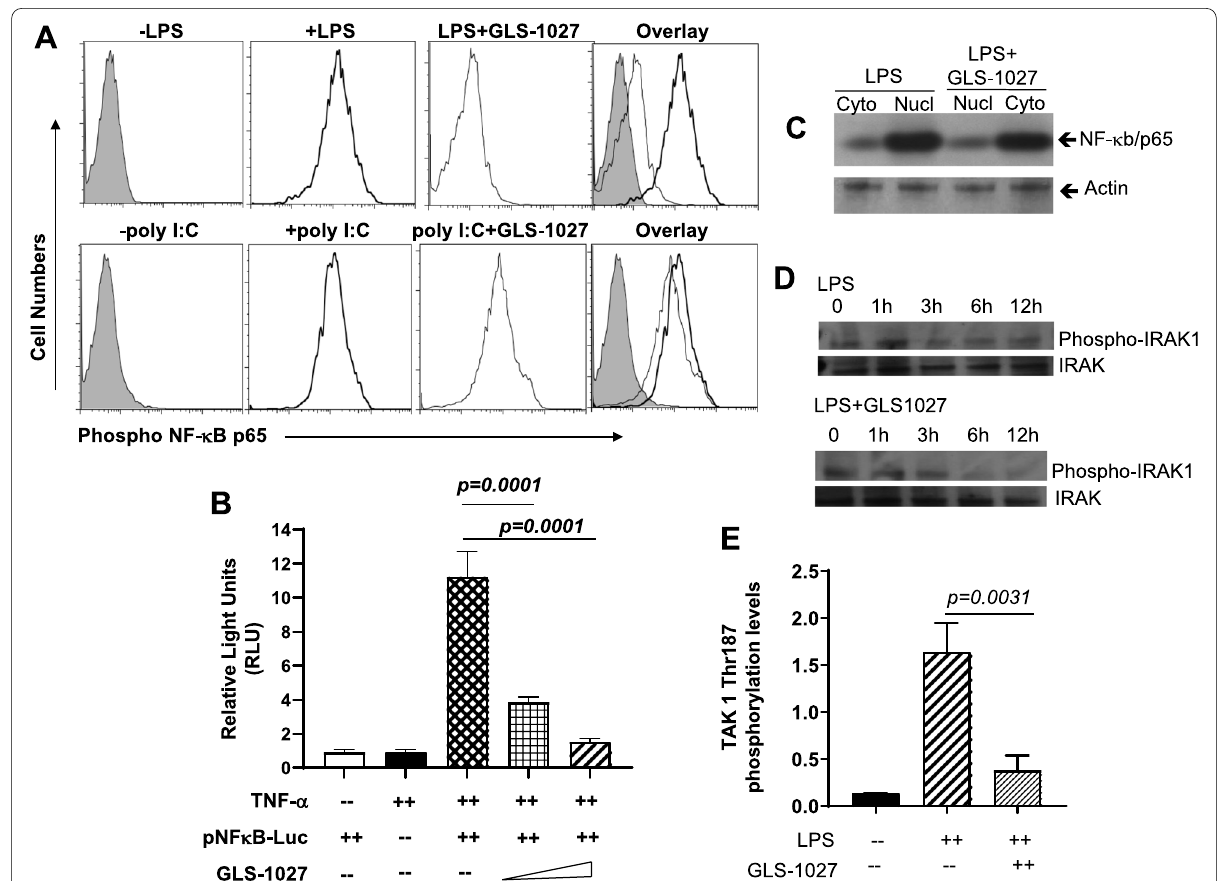
Fig. 2 GLS-1027 inhibits the activation of NF-κB and p38 pathways induced by LPS, but not by Poly(I:C). ( A ) Flow-cytometric analysis of phospho NF-κB -p65 in monocytes after LPS and poly I:C stimulation in the presence or absence of 10 µM of GLS-1027 in vitro. After stimulation, cells were fixed and permeabilized. The cells were stained with fluorochrome-conjugated antibodies against the CD14 monocyte cell surface marker and phospho NF-κB -p65. The CD14-positive monocyte population was analyzed for intracellular levels of phosphorylated NF-κB using flow cytometry with the data displayed as histograms. ( B ) Inhibition by GLS-1027 of NF-κB (p65) DNA binding activity in TNF-α stimulated cells. Nuclear extracts were obtained from unstimulated and TNF-α stimulated at indicated time points in the presence or absence of GLS-1027 (1 and 10 µM) cells and DNA-binding activity was examined by ELISA based EMSA assay. To confirm the specificity of this assay competitor oligo used as control. Data shown are representative of two independent experiments. ( C ) Cells were stimulated with TNF-α with or without GLS-1027 (10 µM) for 3-5 h. Cells were fixed and stained with an anti-NF-κB (p65) antibody, followed by anti-rabbit secondary antibody. ( D‑E ) Phosphorylation of TAK1/IRAK1 is inhibited with GLS-1027. Human primary macrophages were treated with TNF-α and LPS, in the presence or absence of 10 µM of GLS-1027. The activation status of TAK1/IRAK was examined in the cell lysates by immunoblot analysis using the phospho-IRAK (T209) antibody ( D ) and phospho TAK1 activity was determined using ELISA ( E ), as described in Materials and